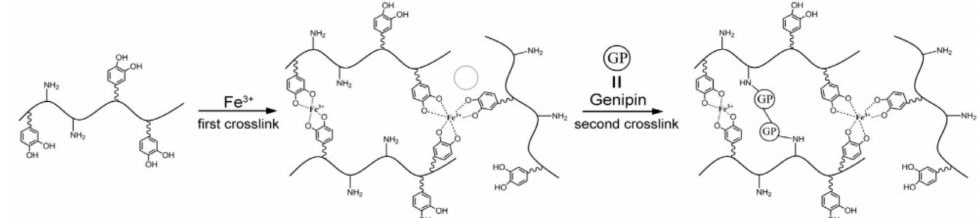
Figure 6. Double cross-linking and formation of hydrogels. Reproduced with permission from Ref. [71], Copyright 2016, Acta Materialia